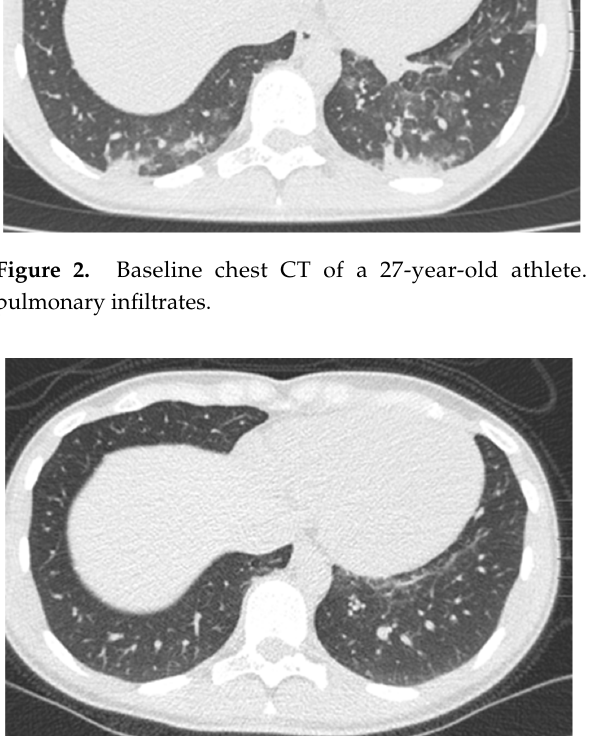
Figure 3. Control chest CT: regression, discrete reticulation.